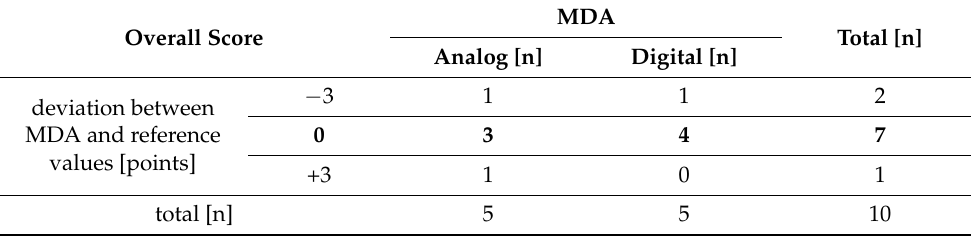
Table 5. Results for the “overall score”—deviation between the MDA and reference values for the analog (n = 5) and digital (n = 5) MDA. The absence of deviation from the reference value is shown in bold